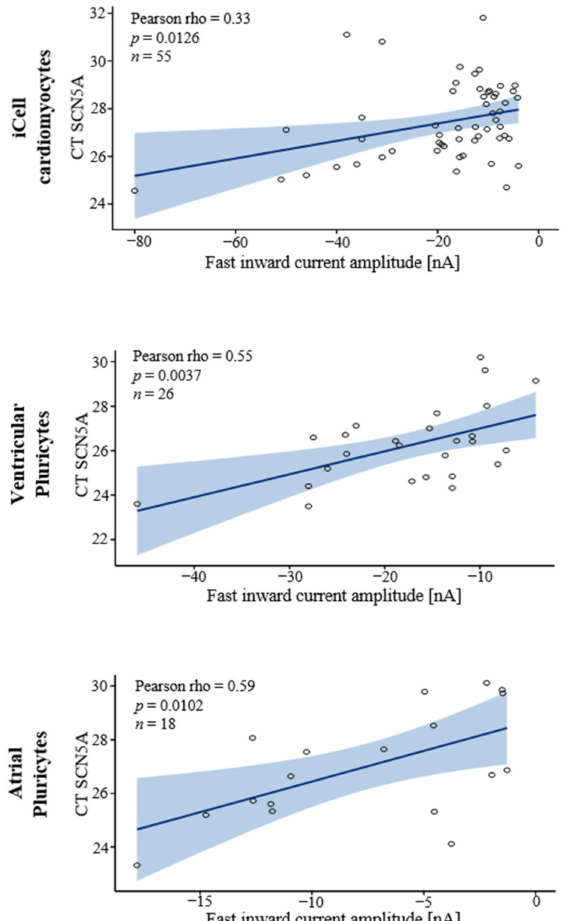
Figure 4. Correlation of SCNA5 expression with the fast inward current. For all three hiPSC-CM groups, CT of SCN5A correlates significantly with the fast inward current amplitude. Blue shaded area indicates 95% confidence